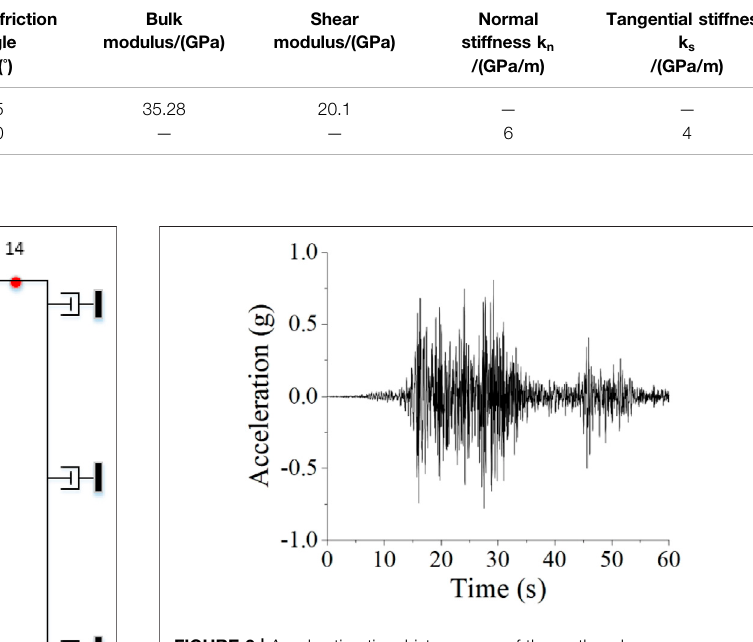
FIGURE 2 | Acceleration time-history curve of the earthquake wave.